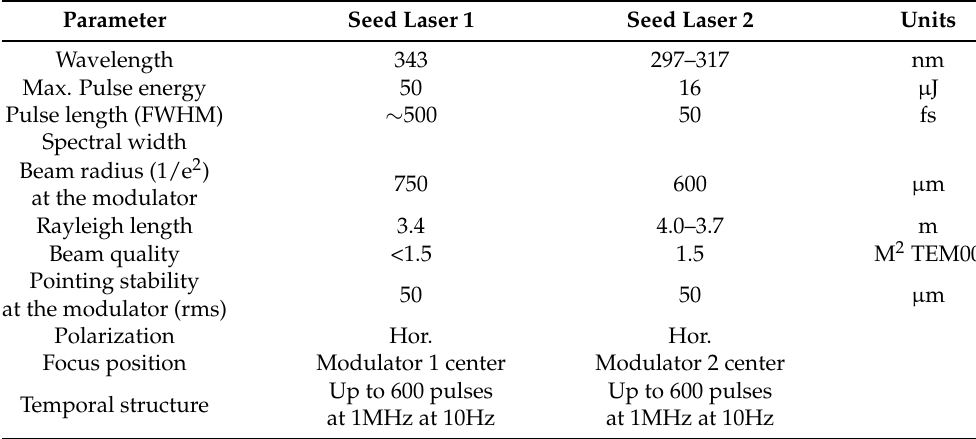
Table 7. Seed laser properties at the